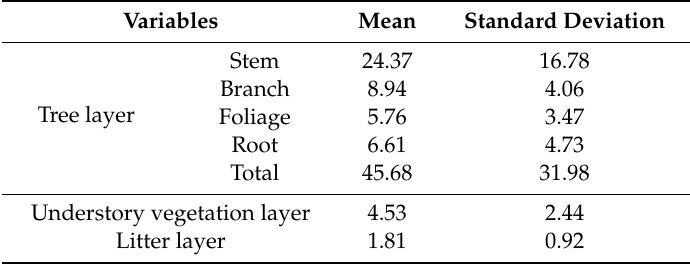
Table 2. Carbon density of tree (including stem, branch, foliage and root), understory vegetation and litter layers in Pinus massoniana forest (Mg · ha − 1